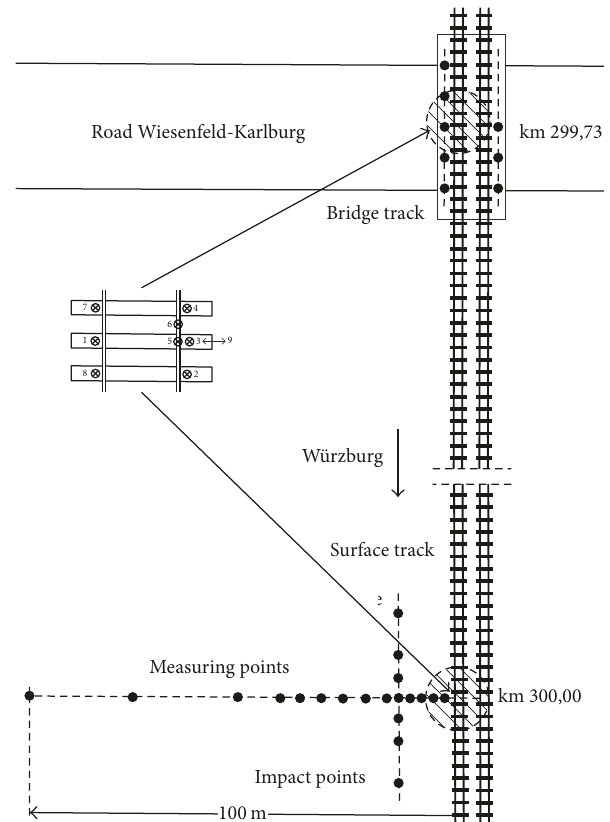
Figure 3: Measurement layout at the surface track (track and soil) and the bridge track (track and